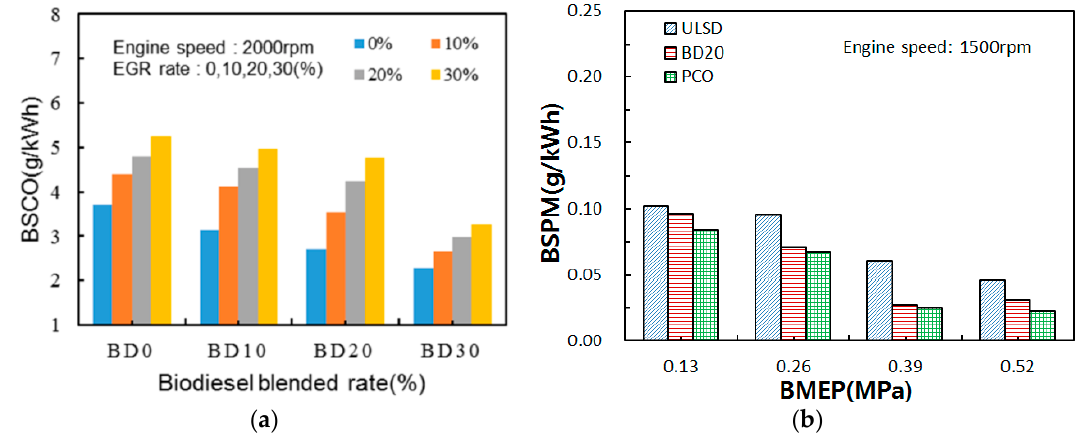
Figure 16. Exhaust emission characteristics of test fuels on ( a ) BSCO: brake specific carbon monoxide (reprodeced with permission from [50], MDPI, 2012) and ( b ) BSPM: brake specific particulate matter.